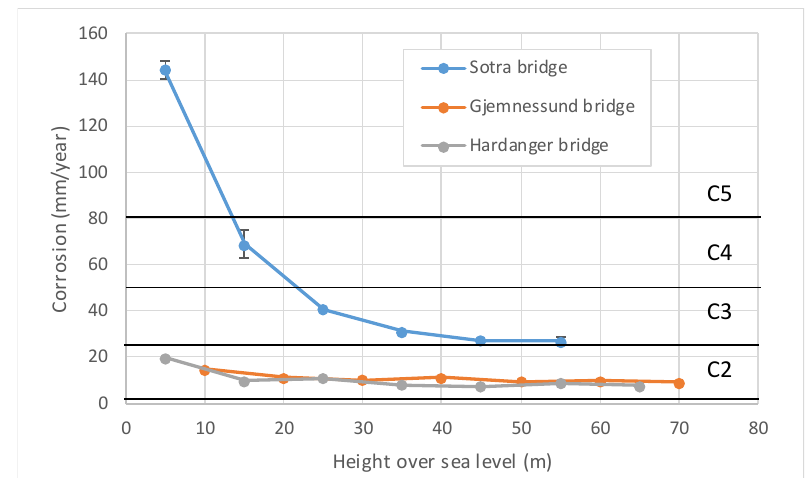
Figure 2. Corrosivity on three bridges as a function of height over sea level.